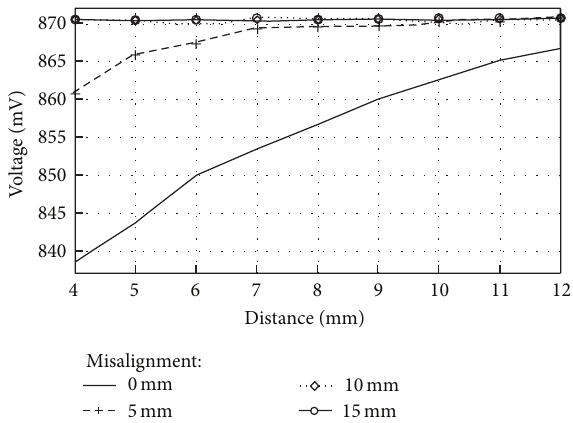
Figure 17: Misalignment between coils. Transmission medium between coils: 1mm of pork skin and 1mm of fat.